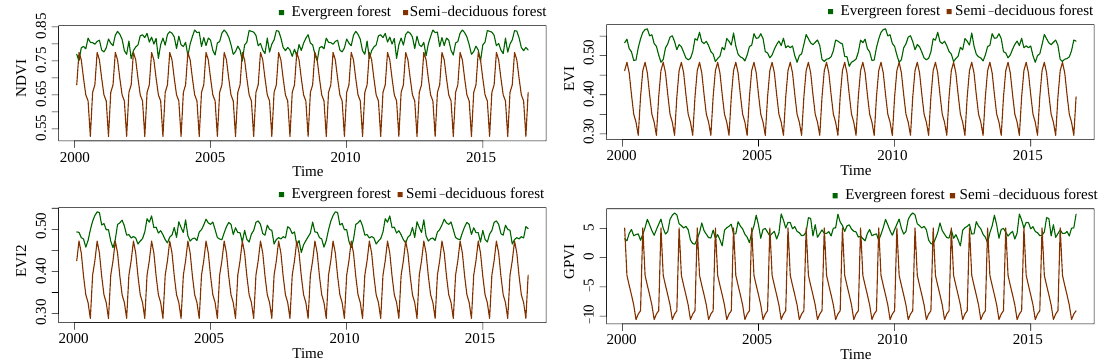
Figure 11. Time series for evergreen forest/semi-deciduous forest discrimination (MODIS).